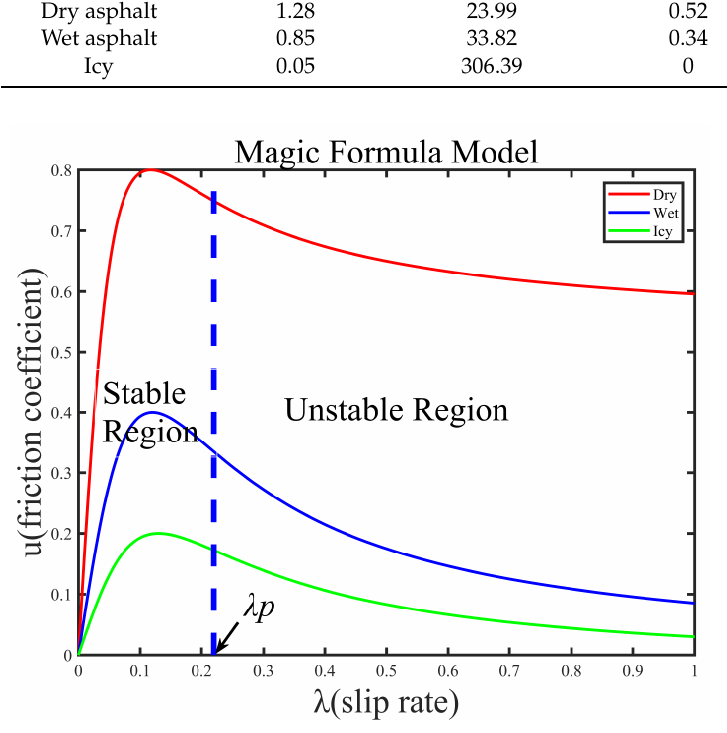
Figure 3. Model of the slip rate andthe coefficient factor for the wheel–runway contact. Figure 3. Model of slip rate and coefficient factor for wheel-runway